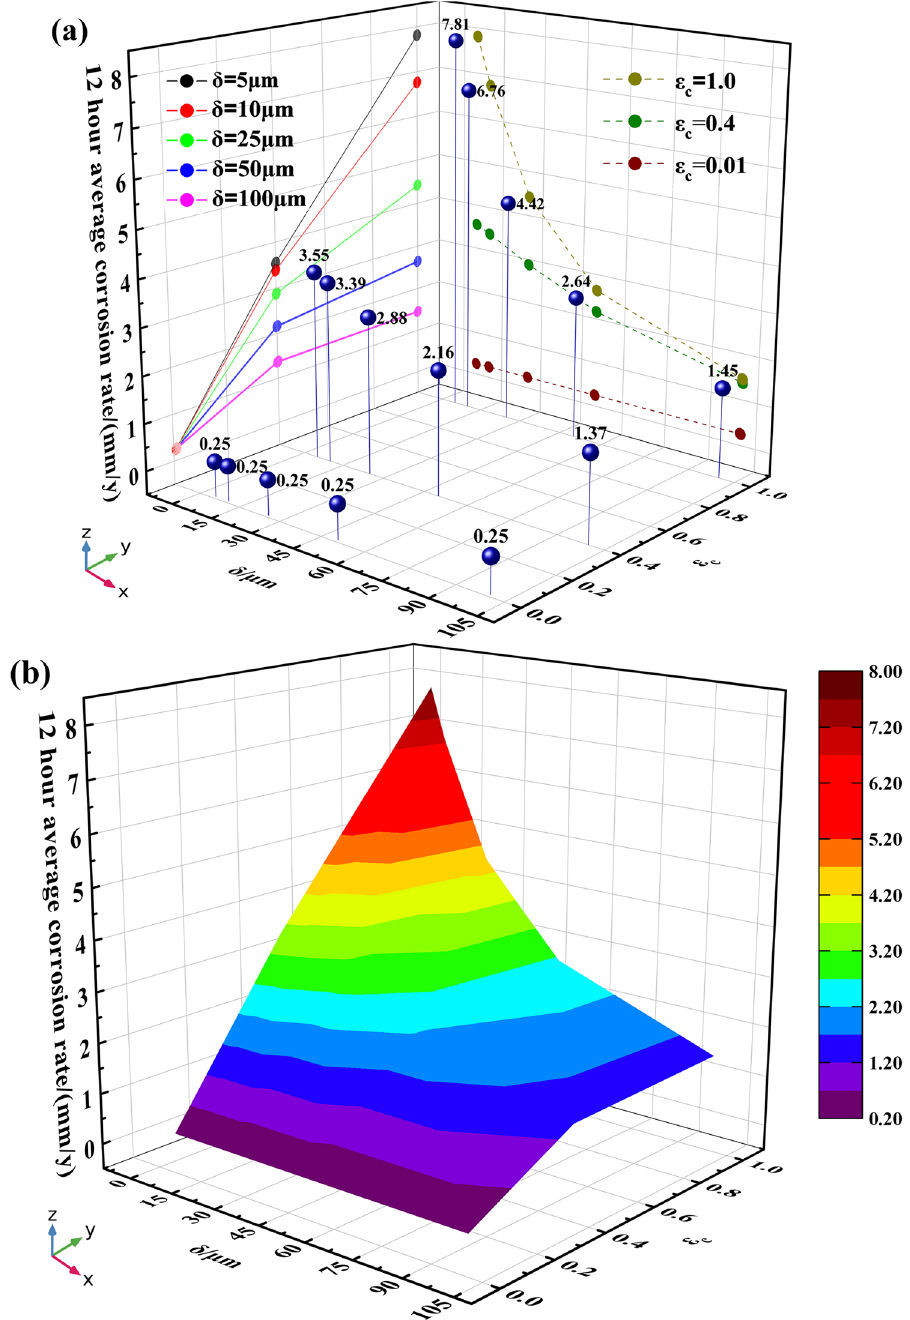
Fig. 7 Average corrosion rate within 12 h under the electrolyte fi lm with different thicknesses and different critical minimum corrosion product porosities. a simulation results. b fi tted surface. Combining Figs. 5 and 6, as the corrosion product porosity decreases, the steric hindrance effect of corrosion products on oxygen diffusion becomes stronger, weakening the in fl uence of electrolyte fi lm thickness on oxygen diffusion. This in fl uence decreases to 0 when the porosity is 0.01, resulting in the oxygen diffusion being independent of the thickness. This explains that although oxygen diffusion is still one of the controlling steps when densifying corrosion products, the corrosion current density is independent of fi lm thickness. If the corrosion product is loose and the electrolyte fi lm is thick, the effect of the loose corrosion product on the path of increased oxygen diffusion is much less Published in partnership with CSCP and USTB npj Materials Degradation (2023)